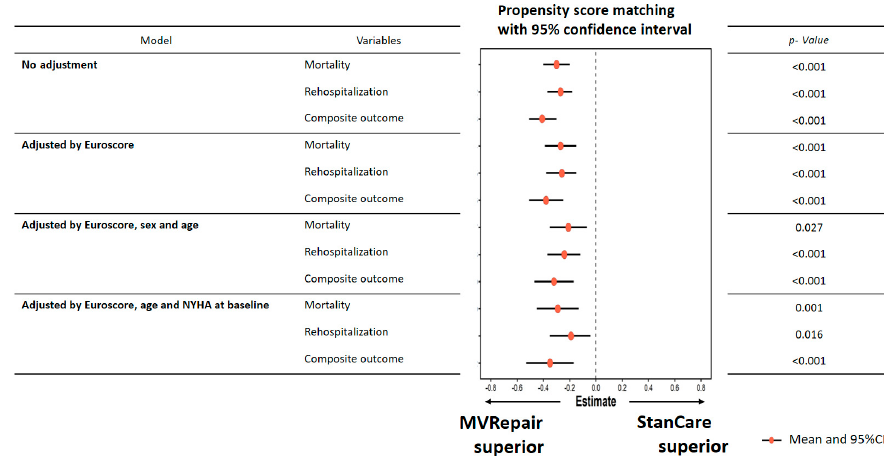
Figure 2. Observed versus expected survival in the MVRepair ( A ) and StanCare groups ( B ).